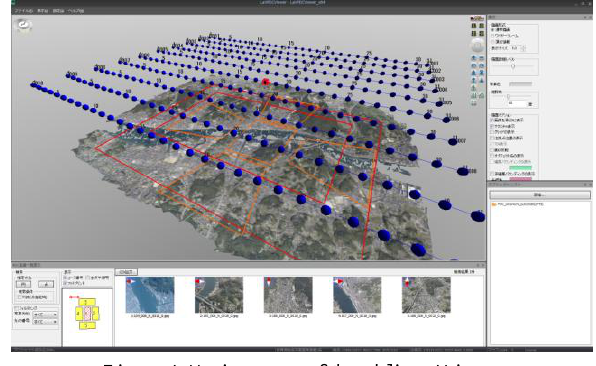
Figure 4. Main screen of the oblique